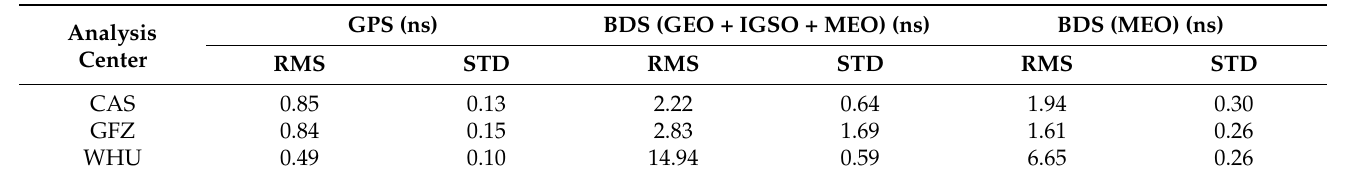
Table 4. Average values of clock offset RMS and STD of GPS and BDS satellites of each analysis